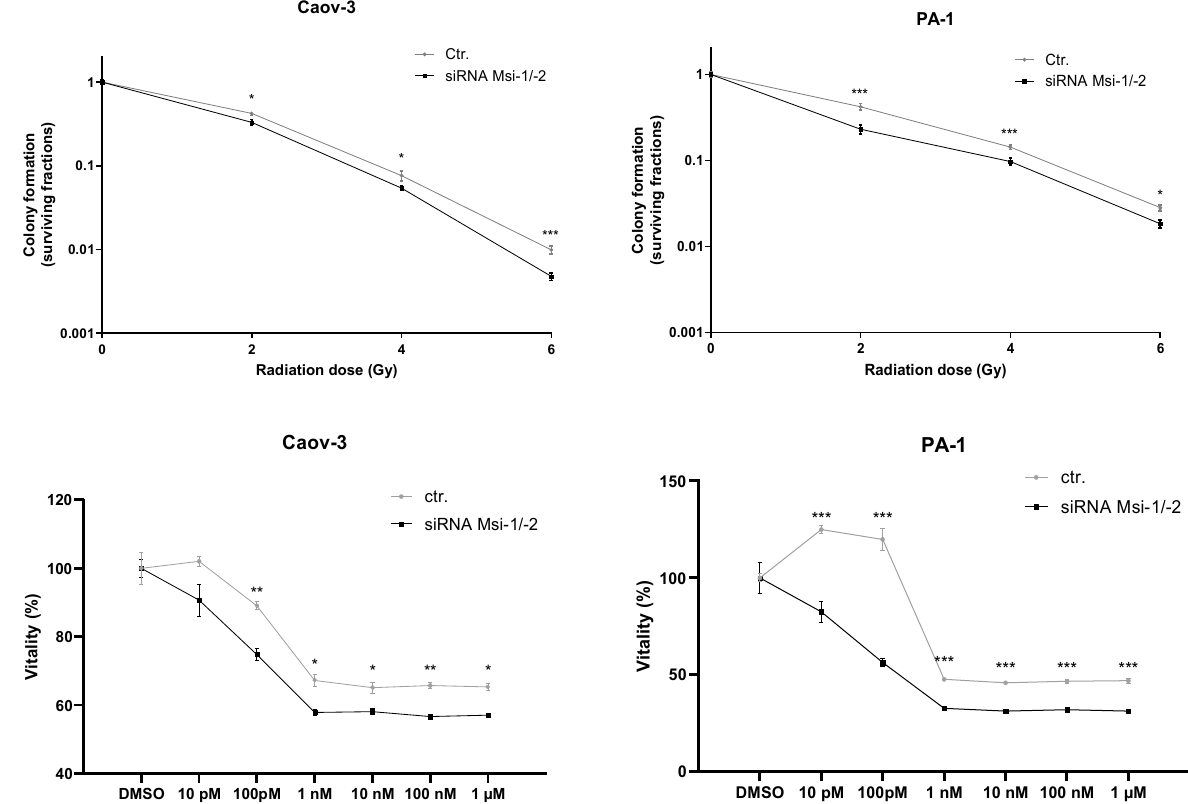
Figure 5. Musashi dual inhibition entails sensitization of ovarian cancer cells to radiation and chemotherapy. ( A ): Musashi knockdown Caov-3 and PA-1 cells consistently demonstrate reduced radioresistance after 2, 4, and 6 Gy of irradiation. ( B ): Caov-3 and PA-1 cells consistently demonstrate reduced chemoresistance to different paclitaxel doses. All experiments were repeated at least three times in duplicates. p values < 0.05 were deemed significant (* p < 0.05; ** p < 0.01; *** p < 0.001; error bars indicate standard error of the mean (s.e.m.)).